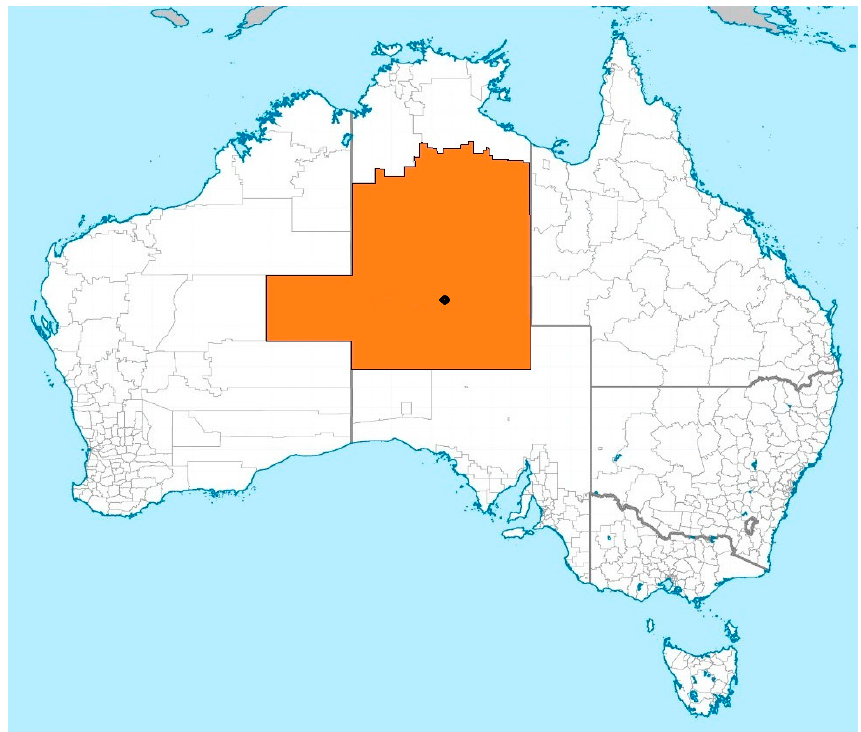
Figure 2. In this research, the ochre coloured area represents the area serviced by the Alice Springs Hospital (marked as ♦ ). Map based on the Local Government Areas [70].